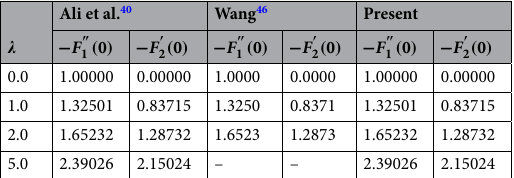
1.0 subject to no effect of =